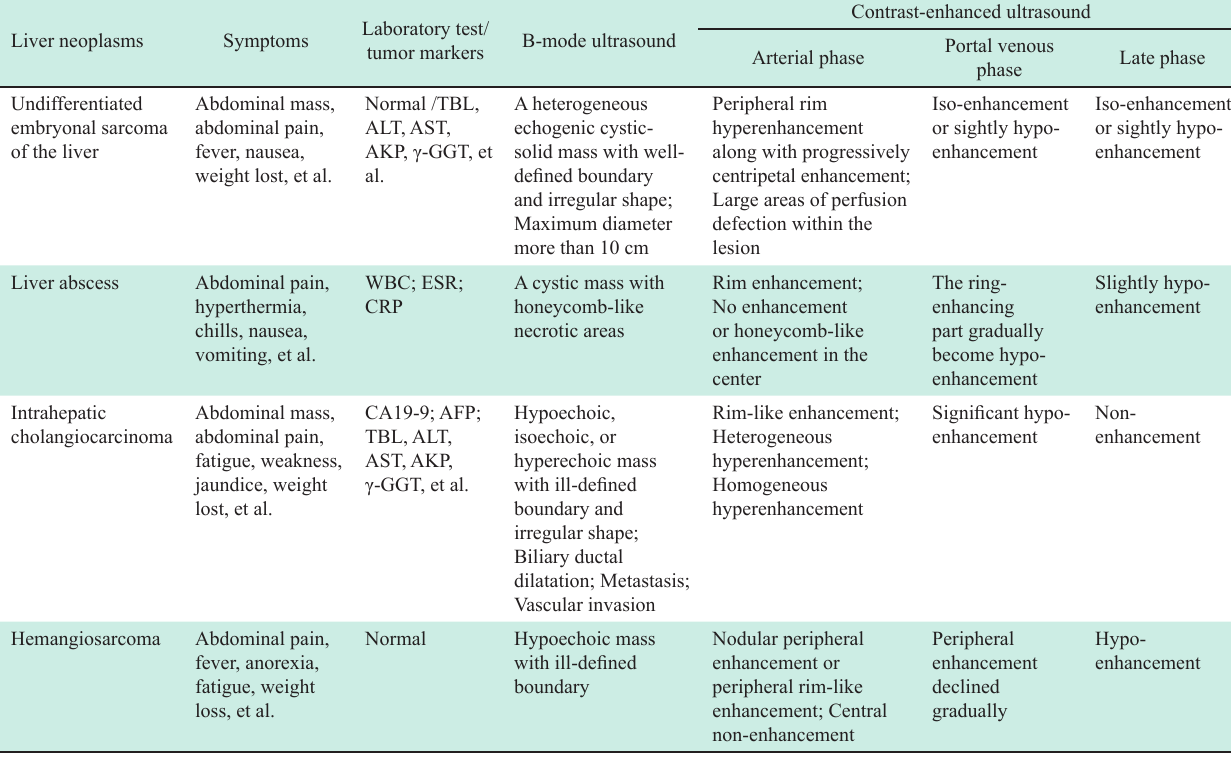
Table 1 Typical contrast-enhanced ultrasonography characteristics of the four liver lesions Liver